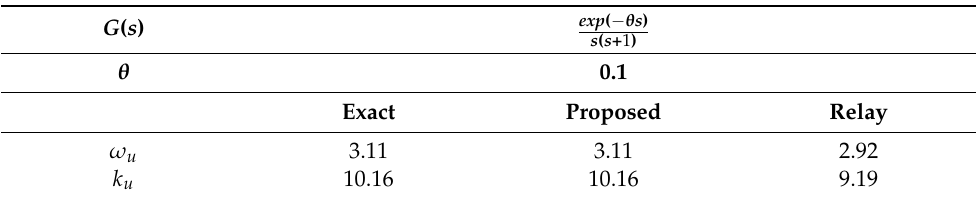
Figure 20. Response of the relay feedback method [1] for the unstable process and PA set = − π . Table 7. Estimates of the proposed method and the relay feedback method [1] for the integrating process and PA set = − π .